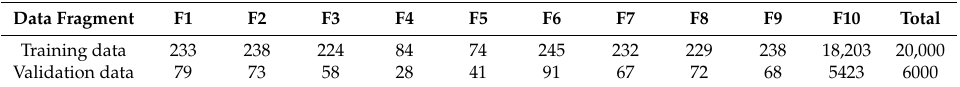
Table 4. Confusion information of the experimental data.